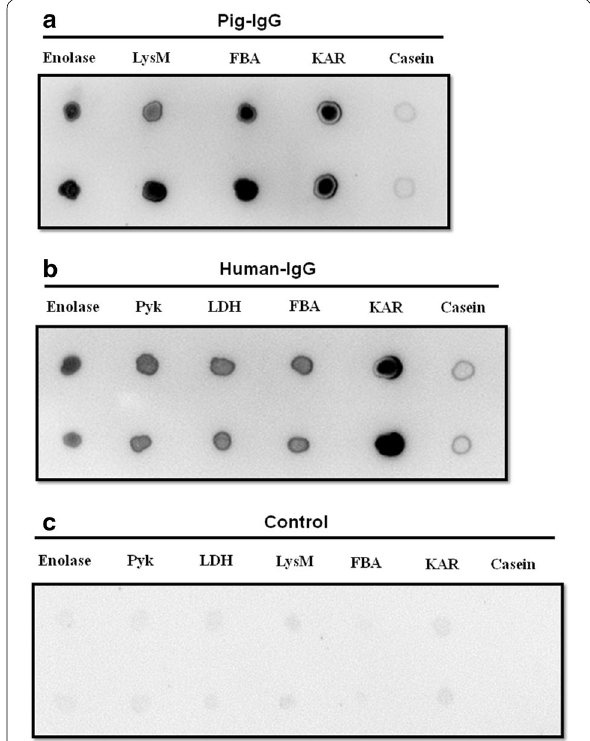
Fig. 3 Identification the binding of pIgG or hIgG to IBPs of S. suis 2 by dot blot. Recombinant pIBPs ( a ) and hIBPs ( b ) were spotted onto the methanol-activated PVDF membranes and incubated with pIgG or hIgG. Bound pIgG or hIgG was recognized with HRP conjugated SPA. Casein was used as a negative control for non-specific binding to IgG and the membrane with HRP conjugated SPA alone were used as a blank control